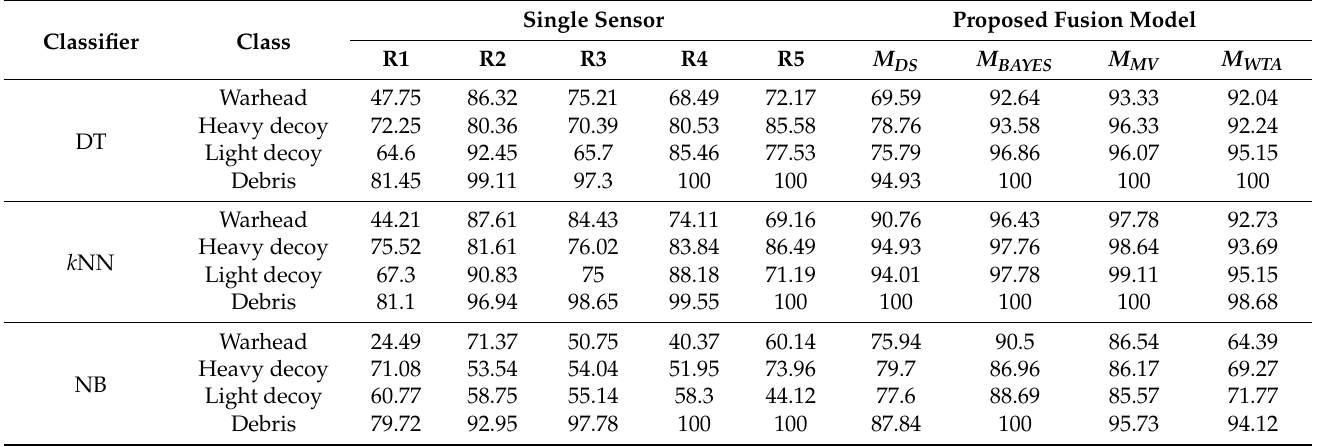
Table 6. F1-scores of four classes in the proposed model with PCA (in